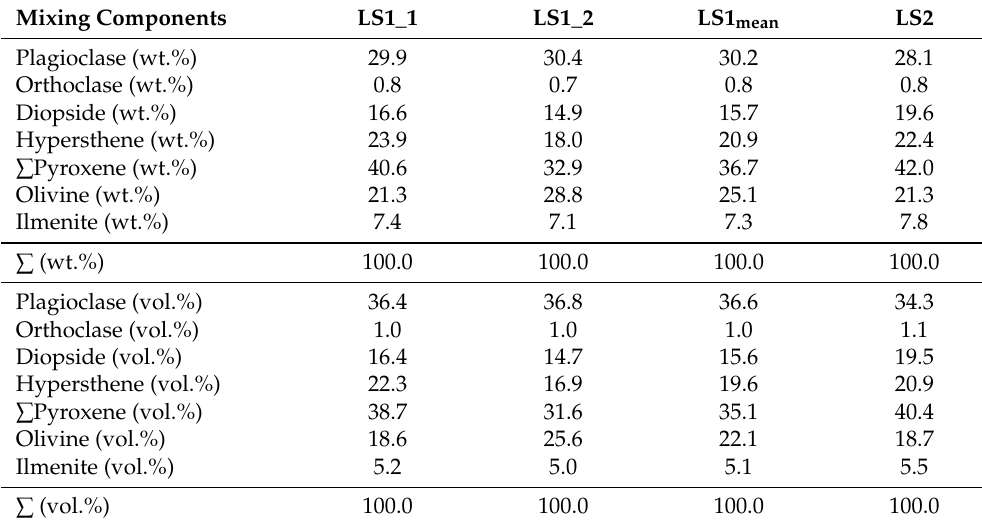
Table A3. CIPW norms for elemental analysis of CE-3 soil samples in wt.% and vol.%. Mixing